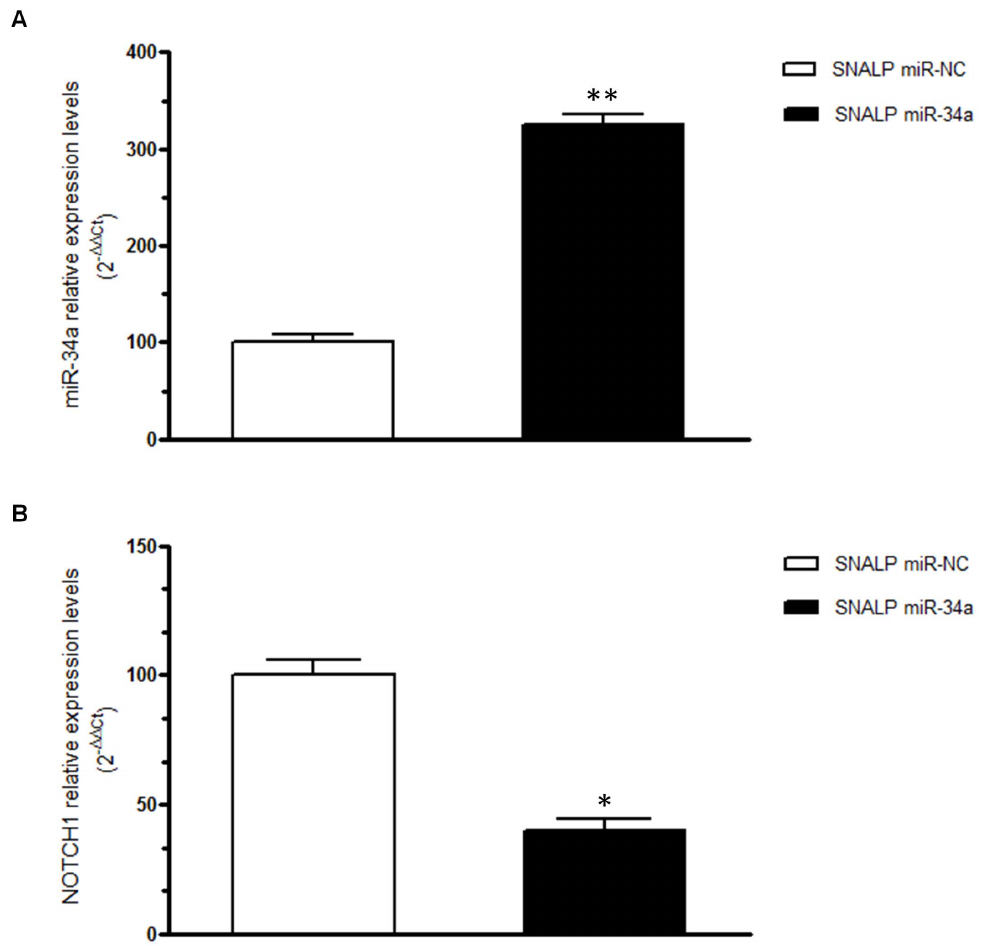
Figure 4. Effects induced by systemic delivery of miR-34a in MM xenografts. miR-34a q-RT-PCR A) and q-RT-PCR of NOTCH1 mRNA expression B) at the end of observation of animal treatments with SNALP miR-34a formulation and SNALP miR-NC as control, in retrieved xenograft SKMM-1 tumors. The results are shown as average of miR-34a or NOTCH1 mRNA expression level after normalization with RNU44 or GAPDH, respectively, and DD Ct calculations. Data represent the average of 3 independent experiments 6 SD. (*) P , 0.05, (**) P , 0.01. either 10% formalin for histology or in RNA later H for RNA isolation.